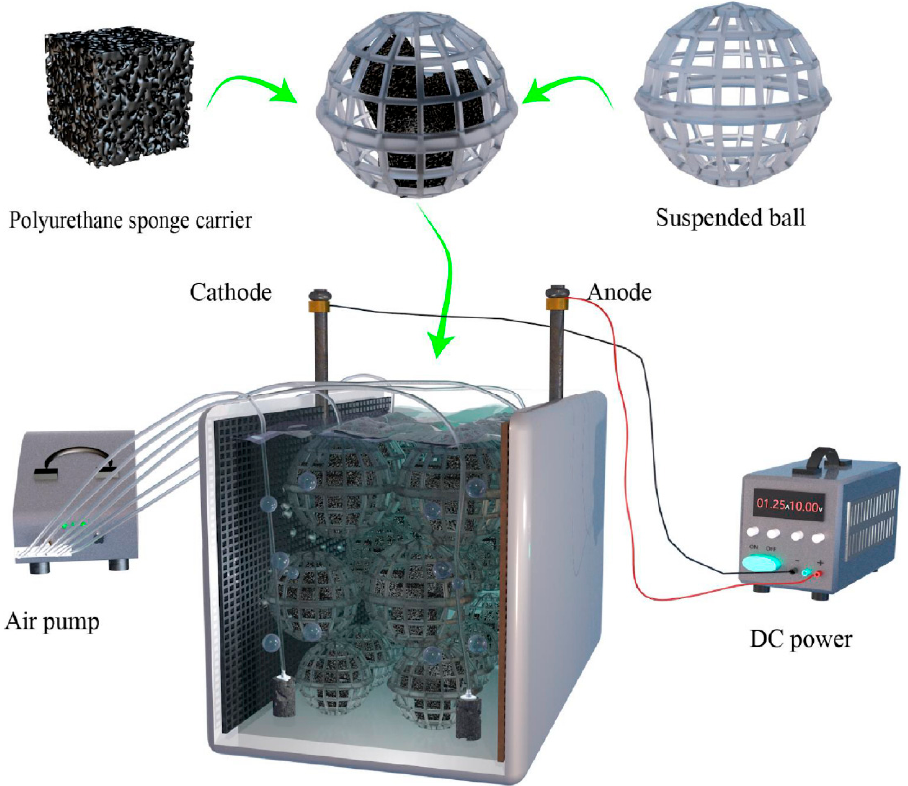
Figure 1. Schematic diagram of 3D-BERs.